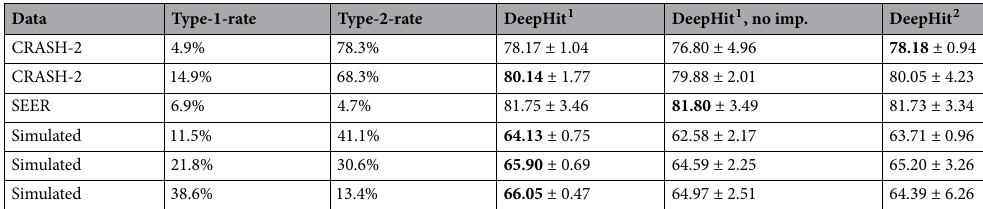
Table 2. Mean estimated C -indices (averaged over time) with estimated standard deviations, as obtained from training the DeepHit architecture on the simulated, CRASH-2, and SEER breast cancer data. DeepHit 1 = DeepHit architecture with one sub-network trained with the preprocessed input data; DeepHit 2 = DeepHit architecture with two subnetworks; DeepHit 1 , no imp. = DeepHit architecture with one sub-network trained on the original input data (treating individuals with observed competing events as censored individuals). Best-performing methods are marked bold. Note that the C -indices must be compared within each row, as the datasets used for training were different in terms of size, censoring, and event rates across the rows. For CRASH-2, in the upper and the lower rows ǫ = 1 indicates death due to bleeding and death due to any recorded cause, respectively. The numbers in this table are obtained from the test datasets.